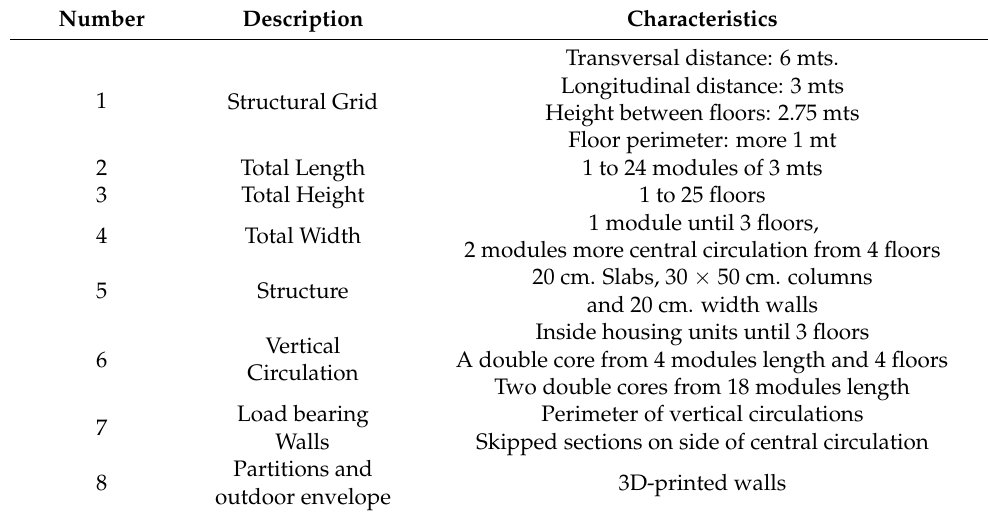
Table 1. Design Conditions of the Building